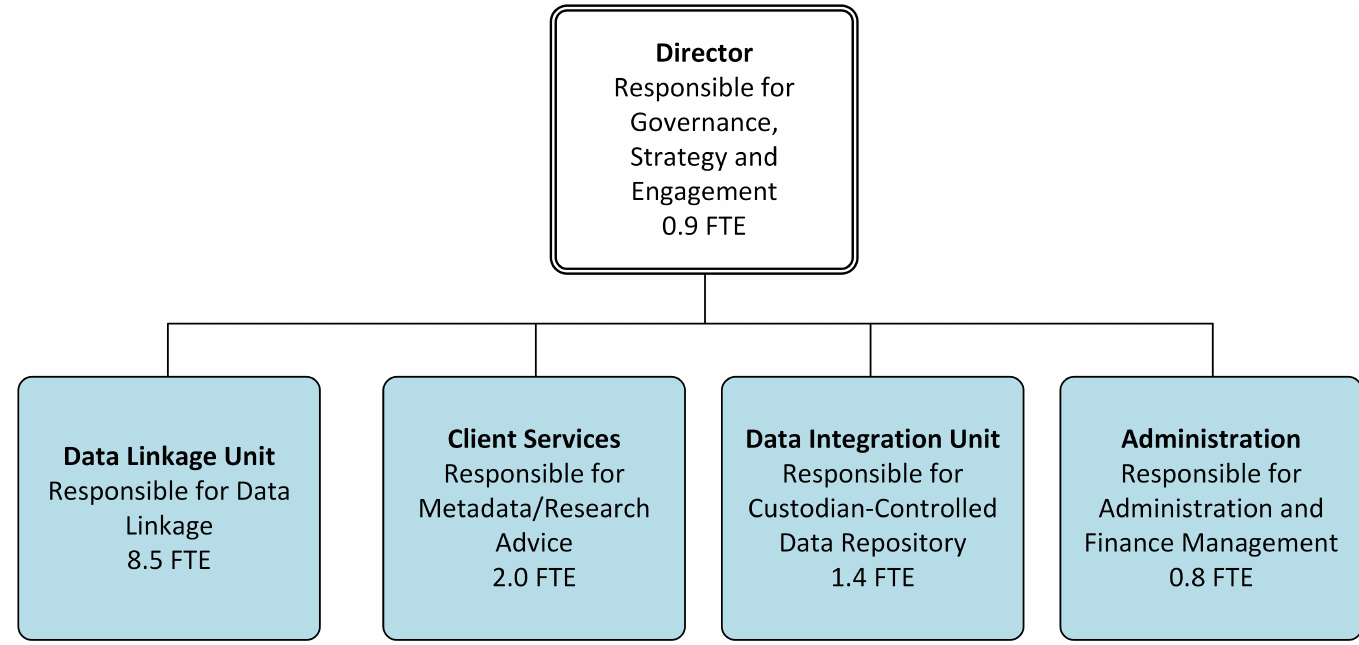
Figure 1: High-level overview of SA NT DataLink’s organisational structure, including responsibilities and full time